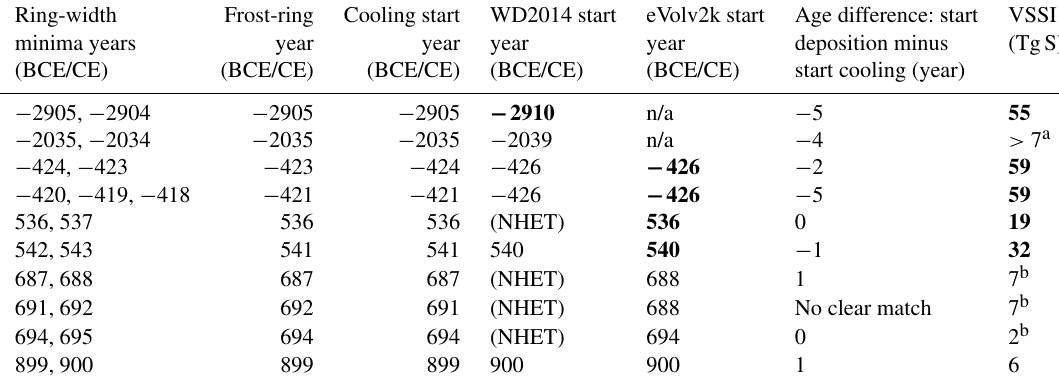
Table 4. Dating assessment using tree rings. Marker events are shown in which a ring-width minima (Salzer et al., 2014) corresponded to a frost-damaged ring within an error margin of ± 1 year (Salzer and Hughes, 2007) in relation to reconstructed volcanic deposition events over the Late Holocene (this study) and the past 2500 years (Toohey and Sigl, 2017). WD2014 ages are provided for bipolar eruption signals (Sigl et al., 2016). Ages from attributed Northern Hemisphere extratropical (NHET) eruptions are on the NS1-2011 chronology (Sigl et al., 2015). Eruptions with VSSI > 10Tg (comparable to Krakatau 1883) within ± 5 years of the cooling start are highlighted in bold. All ages are reported using the ISO 8601 international standard, which does (in contrast to the historical Gregorian calendar) include a year zero. Ring-width Frost-ring Cooling start WD2014 start eVolv2k start Age difference: start VSSI minima years year year year year deposition minus